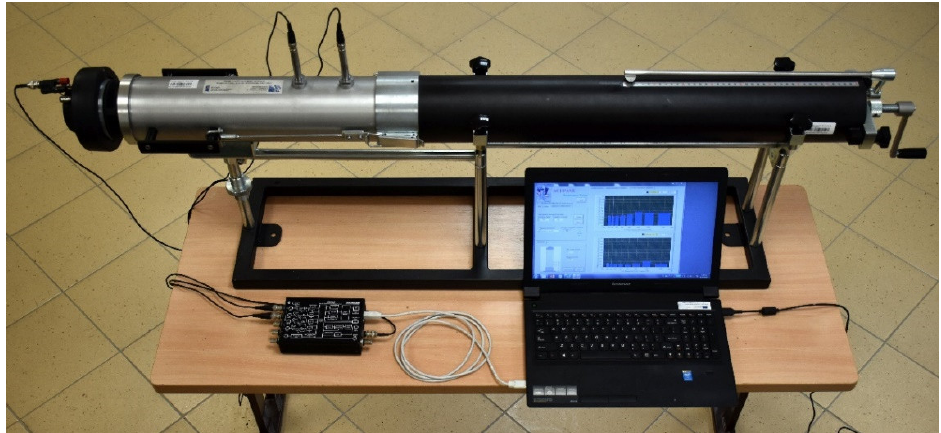
Figure 4. Spectronics ACUPAVE System measurement set.